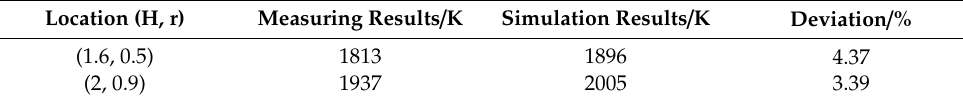
Table 4. Comparison between calculated and measured gas temperatures.